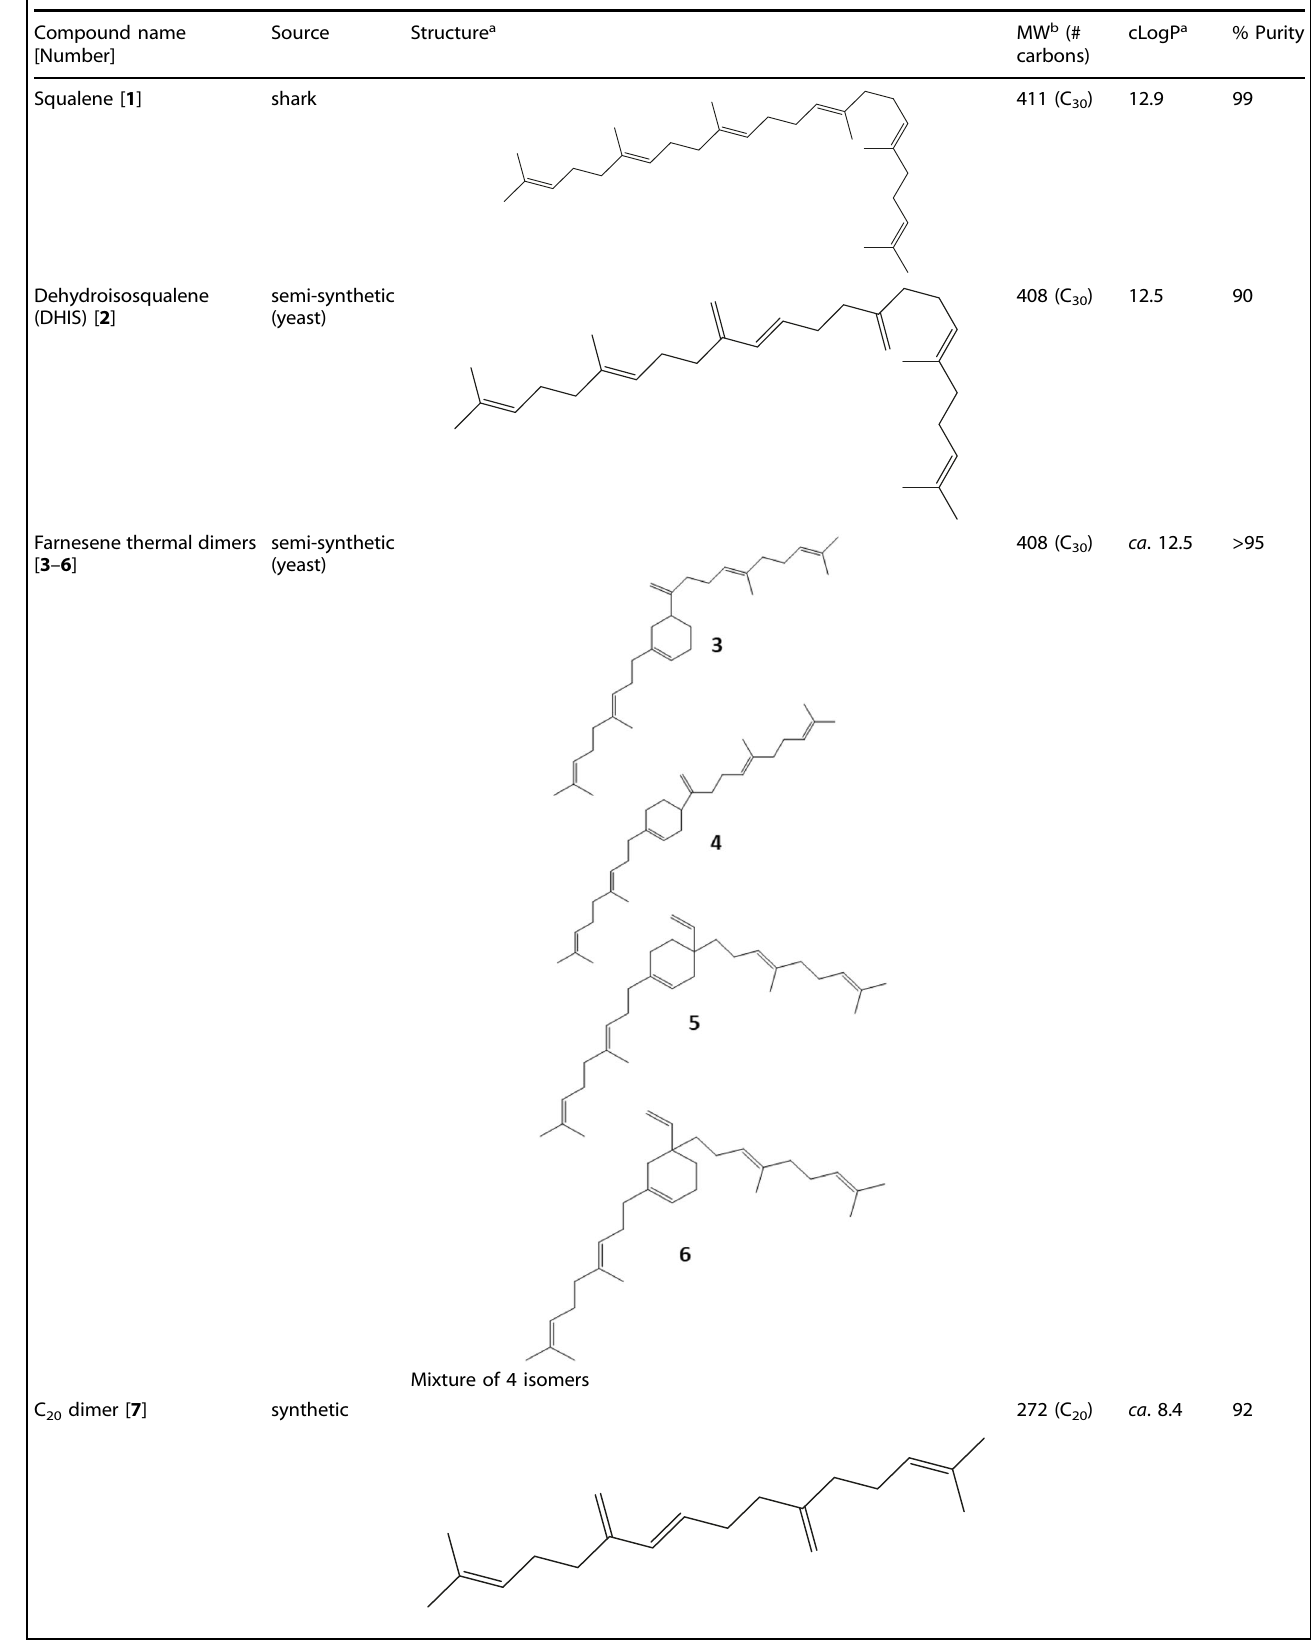
Table 1. Structural properties, source, and purity of terpenoid